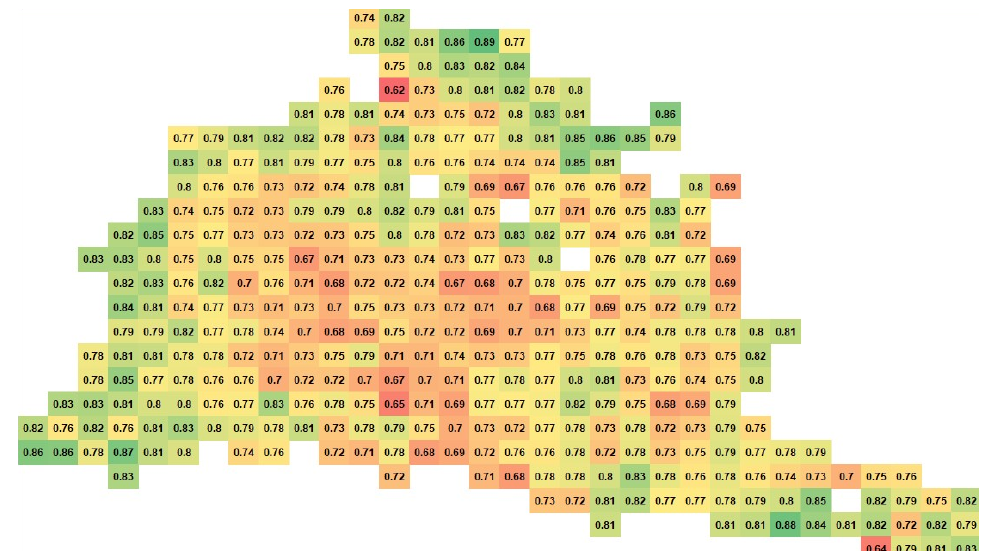
Figure 12. LA spatial analysis of PDR for the first hour of simulation